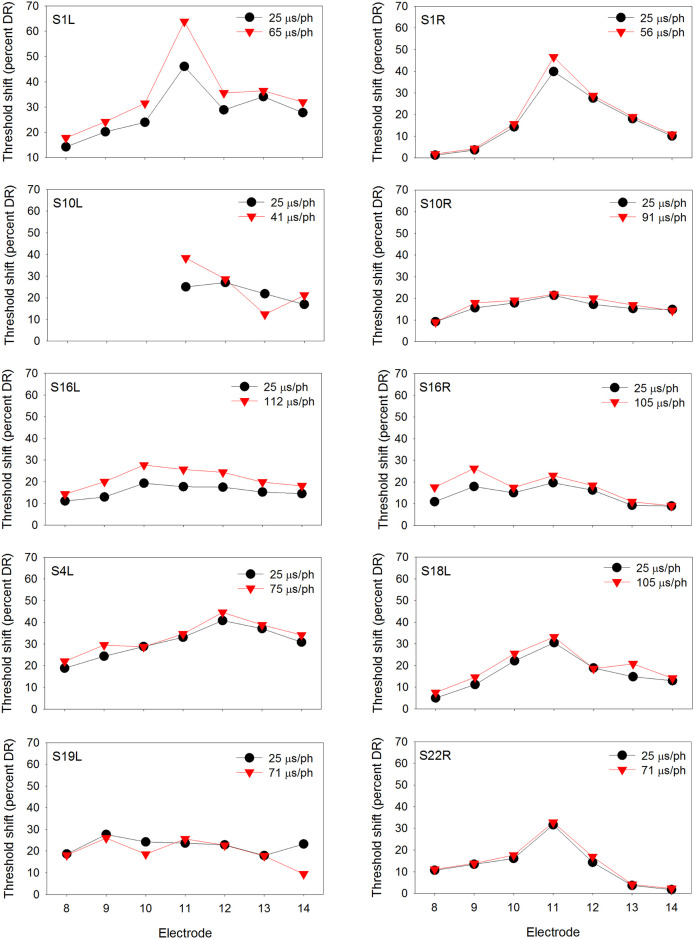
Same as Fig 1, but at the medium presentation level.